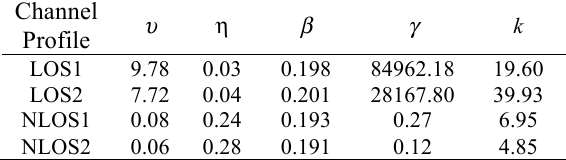
Table 1: υ , η , β , γ and k values for LOS/NLOS scenarios. Channel Profile